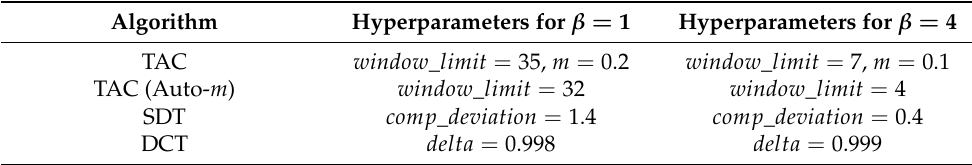
Table 3. Optimal hyperparameters: Dataset 1.